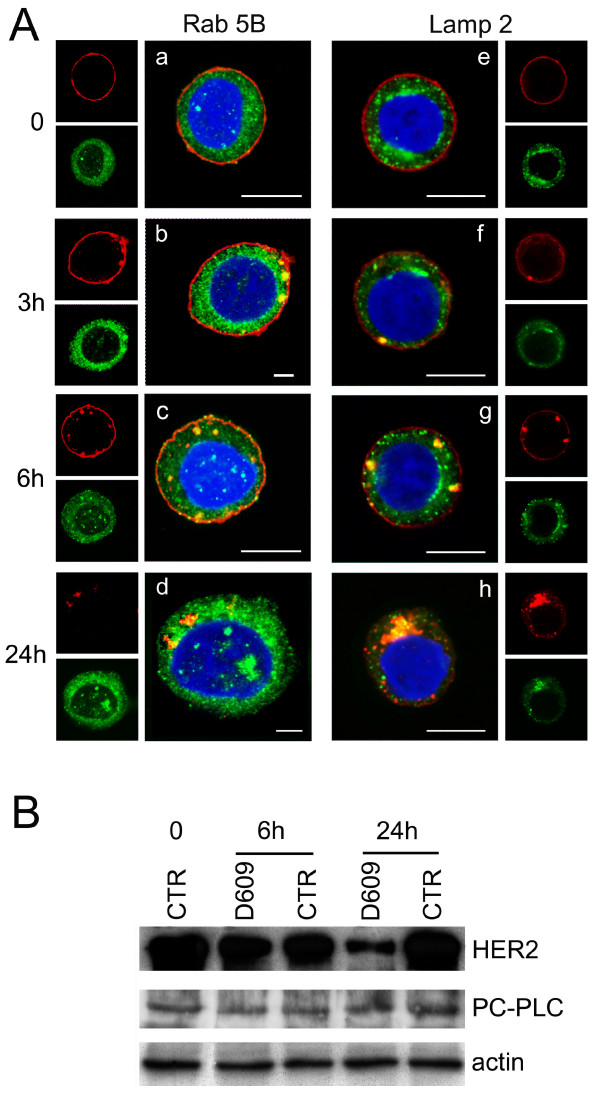
Effects of D609 on trafficking and degradation of HER2 receptor molecules in SKBr3 cells. (a) CLSM analyses of SKBr3 cells, incubated for the indicated time intervals with the PC-PLC inhibitor D609 (50 μg/mL) and then fixed and stained with the α-HER2 mAb W6/100 (red) and α-Rab5B Ab (green, panels a through d) or α-Lamp 2 Ab (green, panels e through h). Nuclei were stained with DAPI (blue). Scale bars, 8 μm. (b) Western blot analyses of total lysates of SKBr3 cells either untreated or incubated with D609 for 6 and 24 hours. The blots were incubated with α-HER2 or α-PC-PLC Abs. Actin was used as quantitative loading control. Experiments shown in panels a and b were independently repeated 3 and 4 times, respectively.